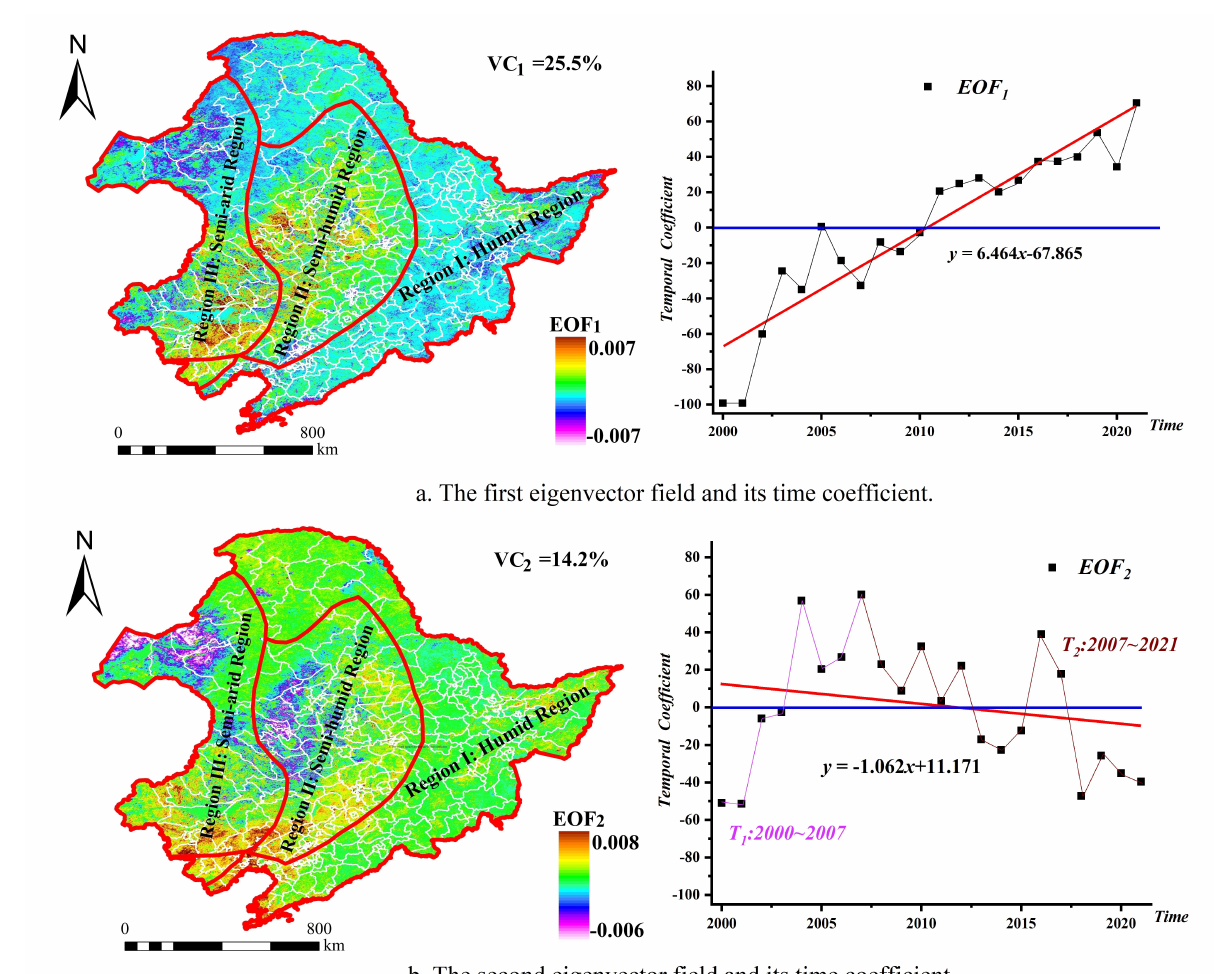
Figure 10. The eigenvector fields and their time